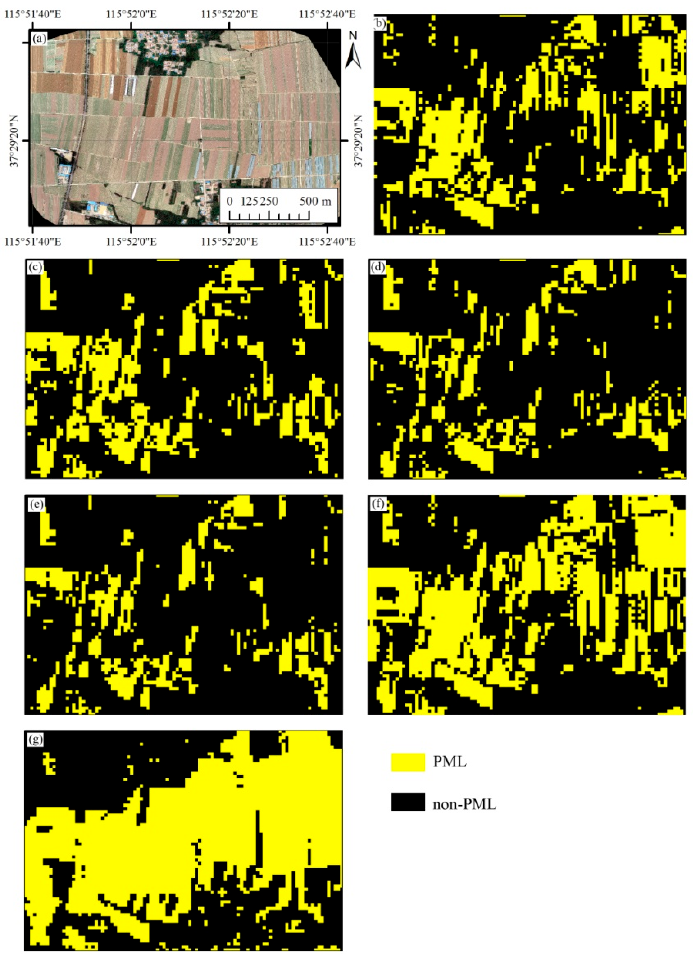
Figure 8. Visual comparison of PML mapping results in the second subset region of HS. ( a ) The UAV images were acquired on June 9 2018, the light-green patterns in the figure are PML at the canopy stage and the white patterns are PML at the plastic-film-covered stage. ( b ) PML mapping results of PMLI using the MTPML workflow. ( c ) PML mapping results of PMLI_NIR using the MTPML workflow. ( d ) PML mapping results of PMLI_SWIR using the MTPML workflow. ( e ) PML mapping results of PMLI_ND using the MTPML workflow. ( f ) PML mapping results of RF using the MTPML workflow. ( g ) PML mapping results of